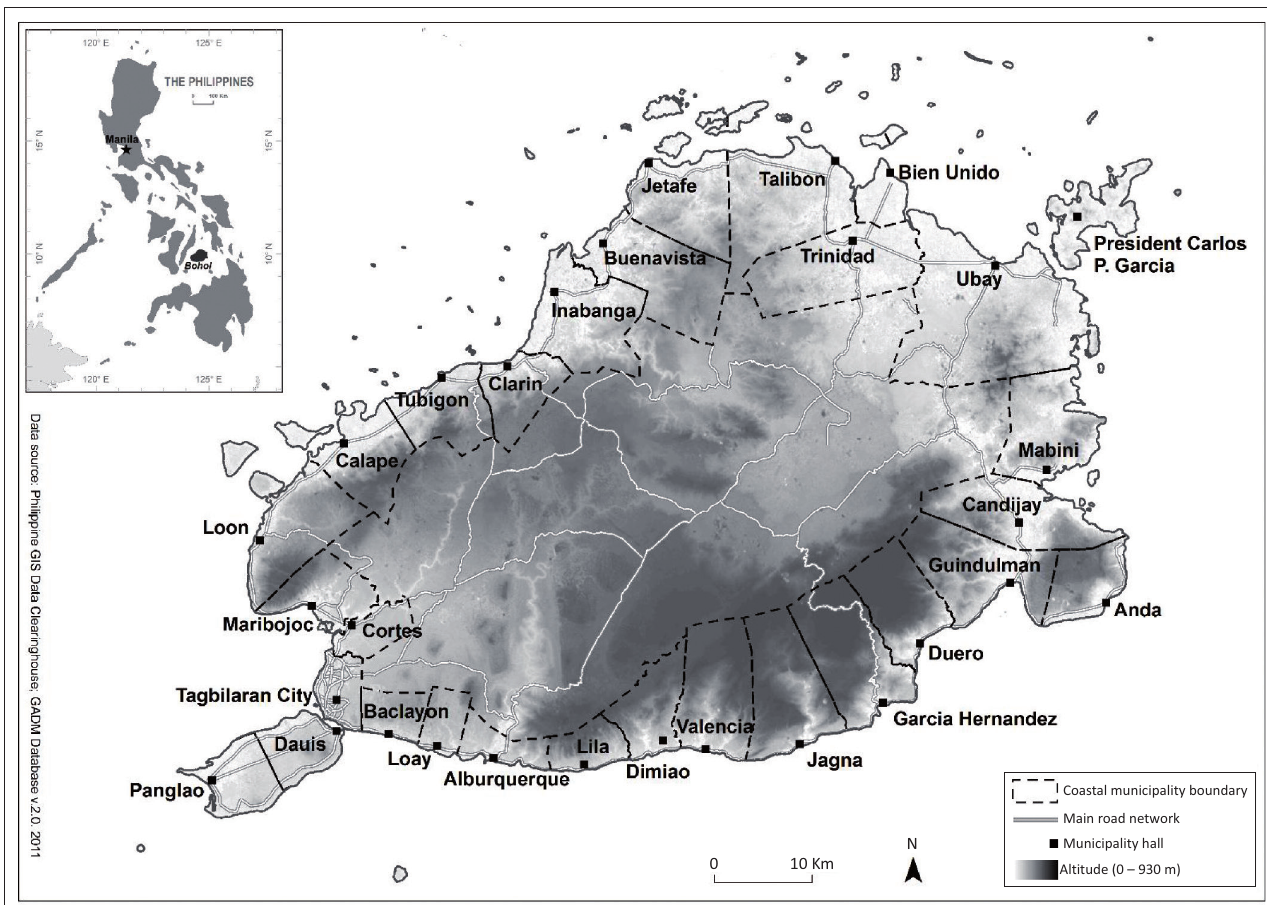
FIGURE 1: Location of Bohol within the Philippines and coastal municipalities